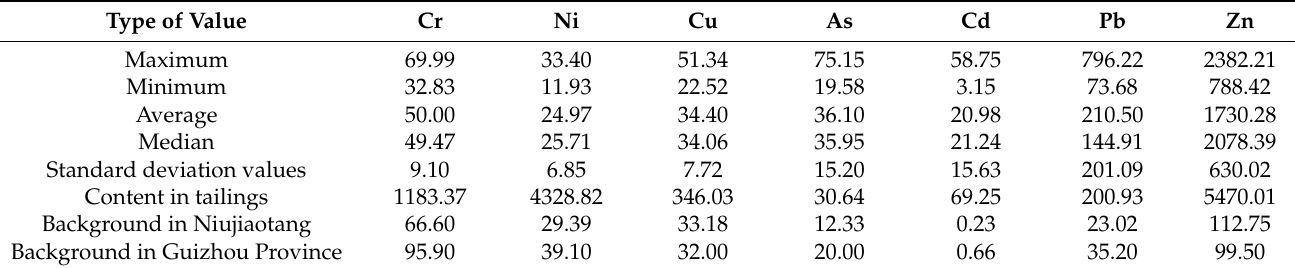
Figure 3. Physical and chemical properties of water samples: ( a ) pH; ( b ) redox potential Eh; ( c ) electrical conductivity EC. Table 4. Concentrations of heavy metals in water samples and respective national standard values Table 5. Contents of heavy metals in the studied soils for Class V surface water (mg/kg).